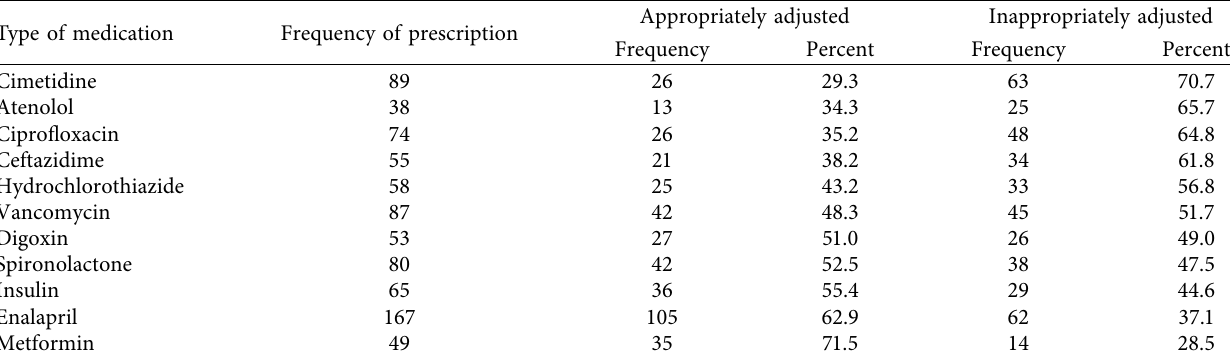
Table 5: Appropriateness of medicines dosage adjustment in patients with renal impairment, who were admitted to medical wards at Amhara region referral hospitals, Ethiopia, in 2020 ( n � 424).